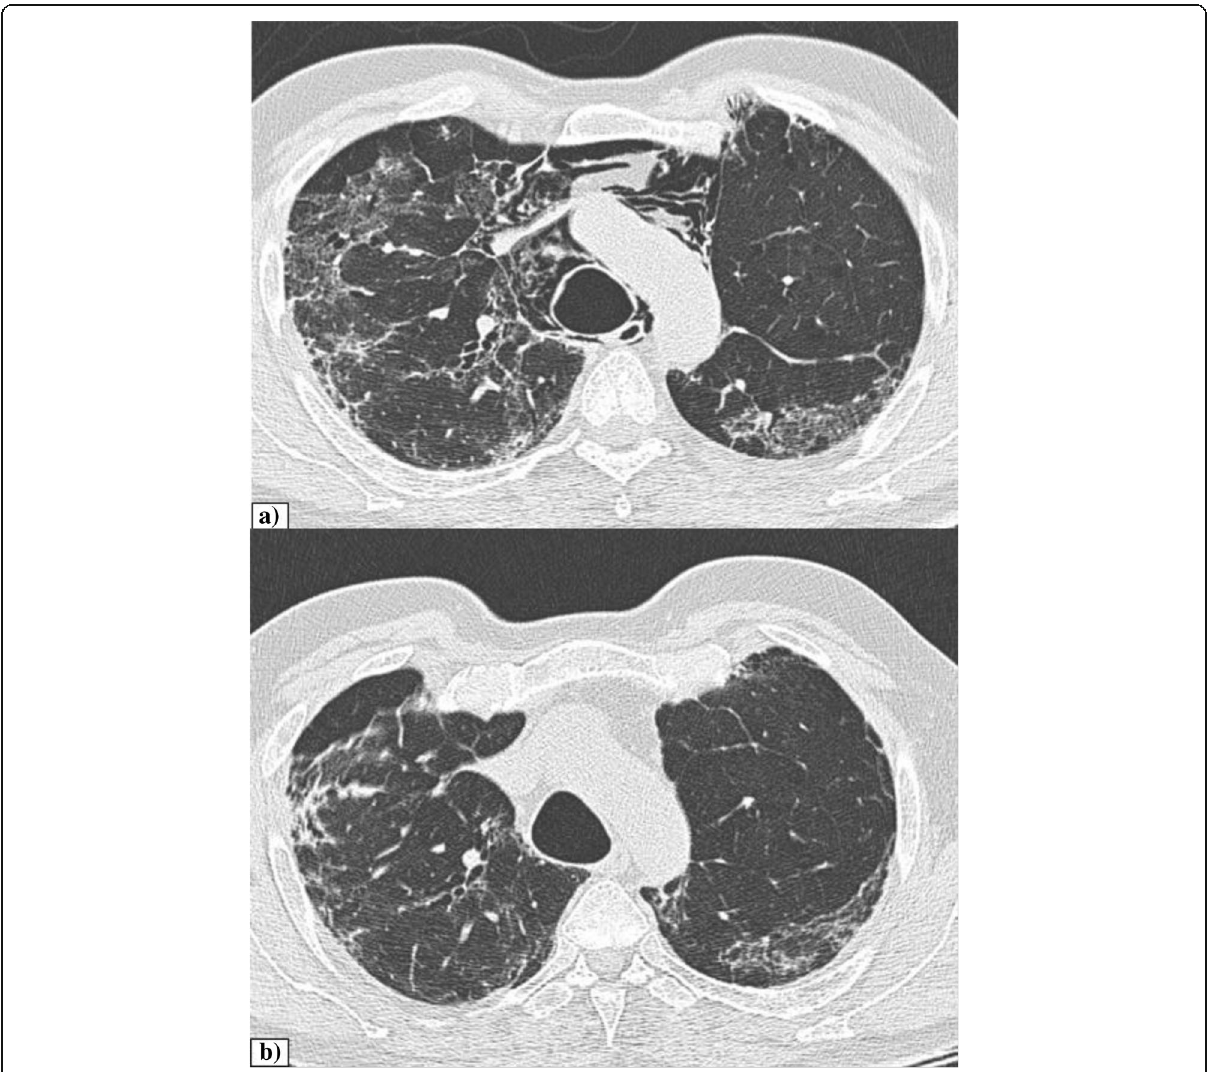
Fig. 5 Spontaneous pneumomediastinum. a Axial CT thorax of a 58-year-old COVID pneumonia patient showing pneumomediastinum in the pre-vascular space and around trachea and esophagus. Visualized lung shows peripheral GGOs with interlobular septal thickening. b Complete resolution of pneumo-mediastinum after 10